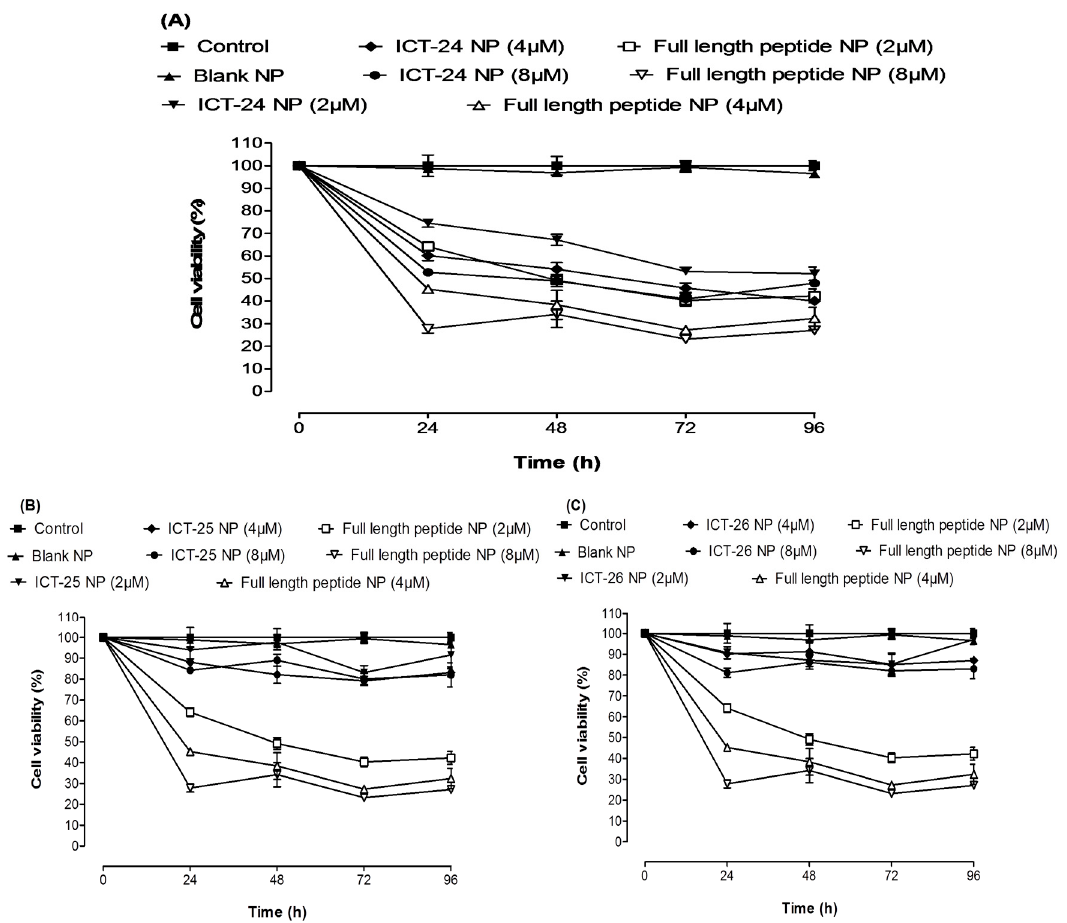
Figure 4. MDA-MB-231 Cell viability results of different doses of deleted peptide NPs and full length NT 3–12 peptide-loaded NP. ICT-24 peptide-loaded NPs ( A ), ICT-25 peptide-loaded NPs ( B ) and ICT- 26 peptide-loaded NPs ( C ) after 24, 48, 72 and 96 h.